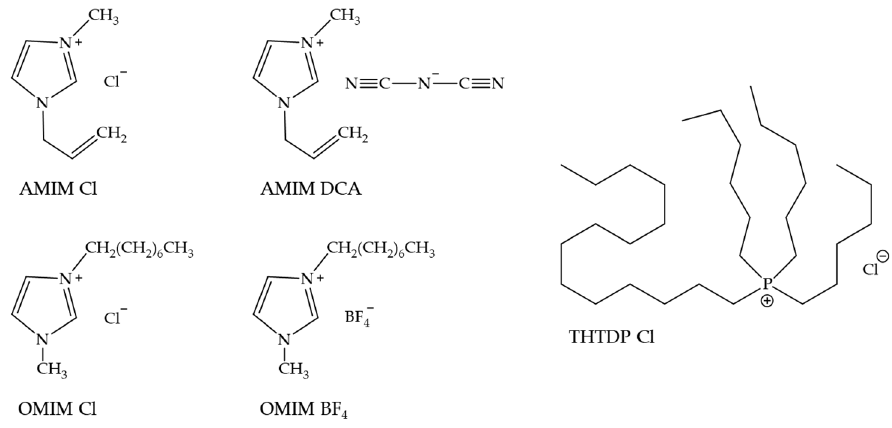
Figure 1. Chemical structures for the used ionic liquids (Ils).